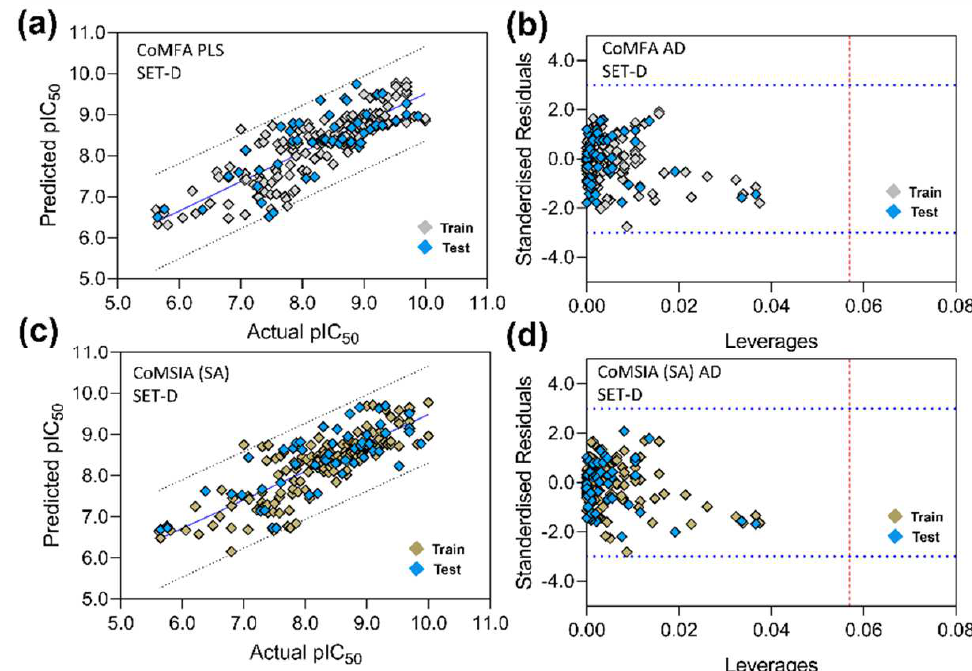
Figure 7. PLS correlation plot and Williams plot analysis of CoMFA and CoMSIA models of PI3K δ . ( a , b ) are the PLS plot and applicability domain analysis by Williams plot of CoMFA model. ( c , d ) are the PLS and Williams plots of the CoMSIA (SA) model. The warning leverage (h*) for CoMFA (h* = 0.056) and CoMSIA (h* = 0.056) are shown in dotted red lines in the Williams plot. Distinctive characteristics were found in CoMFA contour maps of PI3K δ when com- pared to the contours of PI3K γ , as shown in Figure 8c,d. A large green contour appeared around the quinazoline ring near M752, Y813, and I910, and another small green contour appeared at the purine ring near the residue W760. Combining this observation indicated that a bulky steric substitution in such areas could increase the π – π stacking or π – σ in- teractions with the surrounding hydrophobic residues. The presence of a narrow yellow contour also indicated an undesirable site for additional steric substitution and might result in steric clashes. In Figure 8d, two small blue contours near V828 and I910 signify the favorable position for electropositive substitution, which could provide better molecular interaction and inhibitory potency to PI3K δ . A red contour near residue W760 indicates a favorable position for an electronegative substitution, such as carboxyl (-COOH) or keto (-C=O) groups, which could provide additional interactions with surrounding residues. Additional CoMSIA contour maps of PI3K γ and PI3K δ are shown in Figures 9 and S8. The steric and electrostatic fields were already described in the CoMFA; hence, they are not discussed further. The contour maps signifying favorable and unfavorable locations for the hydrophobic H-bond donor and H-bond acceptor are shown in multiple color schemes. The yellow contour represents the beneficial substitution for the hydrophobic chemical entities. Compounds with hydrophobic alkyl or aromatic groups in that region displayed hydrophobic interactions with the residues in the binding pocket. Additionally, in Figure 9b, the cyan and purple contours represent favorable and unfavorable substitutions for the H-bond donor atoms or chemical groups such as nitrogen, amine, and amide. Next, in Figure 9c, the magenta and orange contours represent a favorable or unfavorable substitution for H-bond donors, such as the carboxyl, keto, and sulphone groups, which could increase the inhibitory activity of the compounds. The contour polyhedrons of the H-bond acceptor of PI3K δ (Figure S8) signify the favorable position of the H-bond acceptor